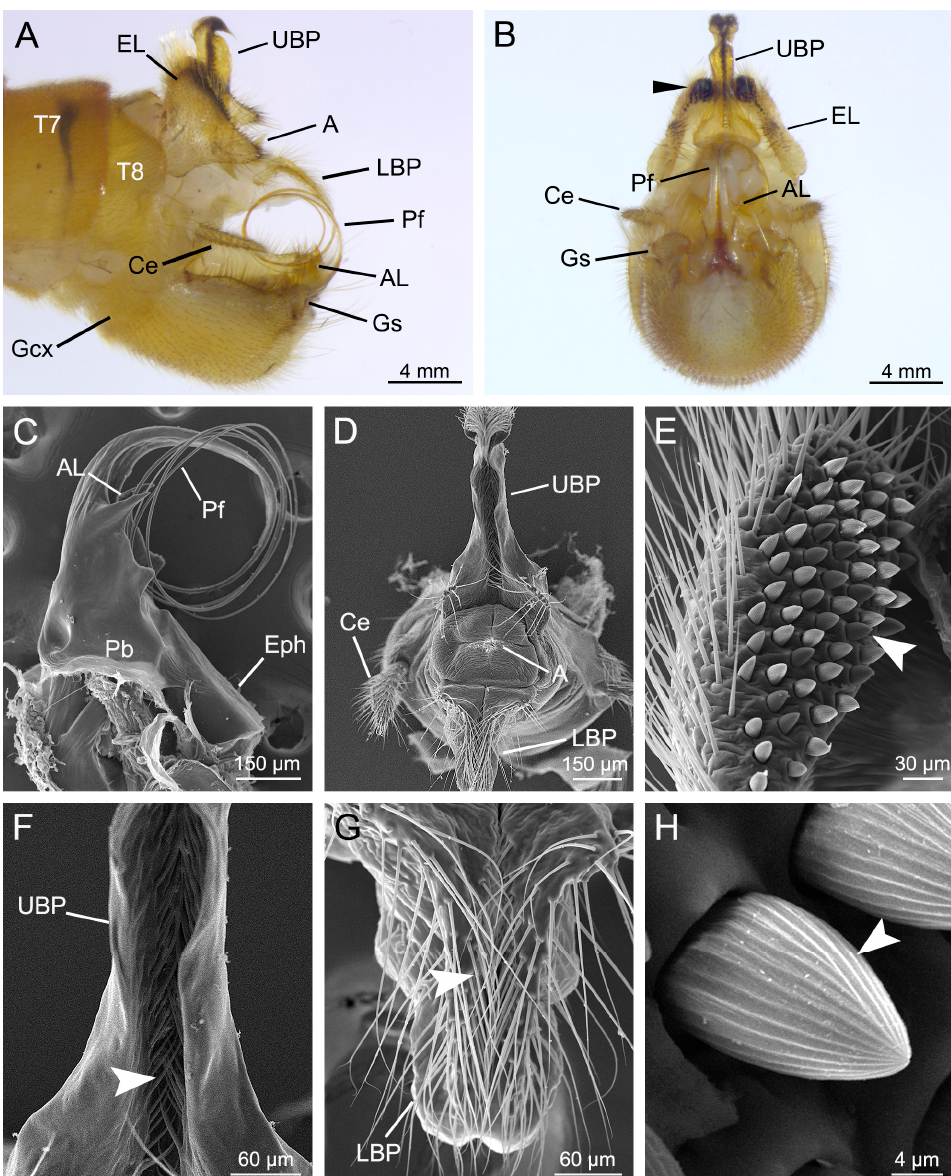
Figure 1. Male genitalia of Terrobittacus implicatus. ( A ) and ( B ) are auto ‐ montage micrographs. ( C − H ) are scanning electron microscopy (SEM) micrographs. ( A ) Male genitalia, lateral view. ( B ) Male genitalia, caudal view. Arrowhead shows spines on the epandrial lobes. ( C ) Aedeagal complex, lateral view. ( D ) Proctiger, caudal view. ( E ) Epandrial lobe, caudal view. Arrowhead shows spines. ( F ) Magnification of the upper branch of proctiger to show the setae (arrowhead). ( G ) Magnification of the lower branch of proctiger to show the setae (arrowhead). ( H ) Magnification of the spine on the epandrial lobe. Arrowhead shows the radial grooves on the spine. Abbreviations: A, anus; AL, aedeagal lobe; Ce, cercus; EL, epandrial lobe; Eph, epiphallus; Gcx, gonocoxite; Gs, gonostylus; LBP, lower branch of proctiger; Pb, phallobase; Pf, penisfilum; UBP, upper branch of proctiger; T7 − T8, terga VII − VIII.